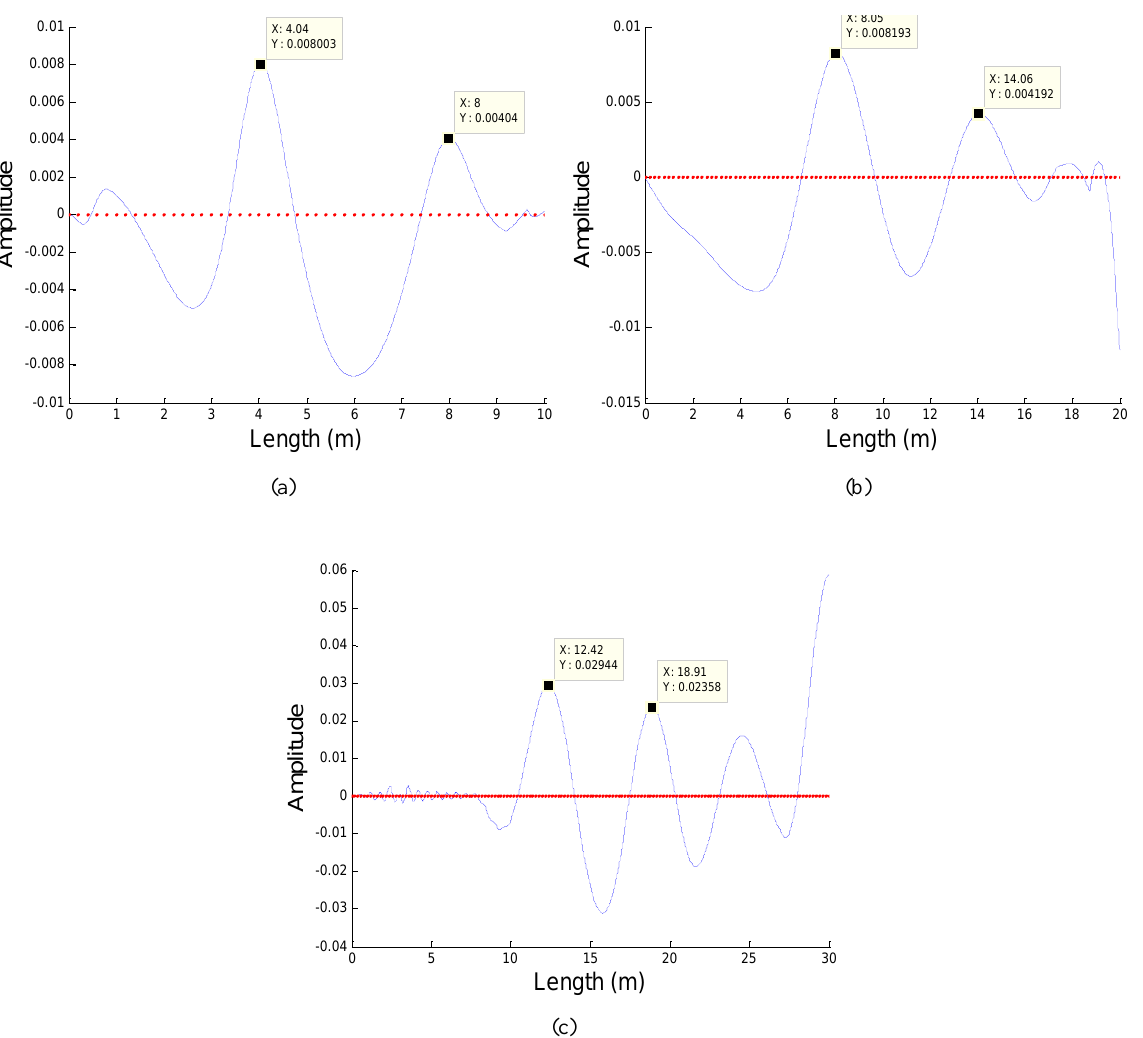
shows that the accuracy of damage location for a SNR of 5 is redsuced due to deviations introduced by noise, but it can still be located within 0.35